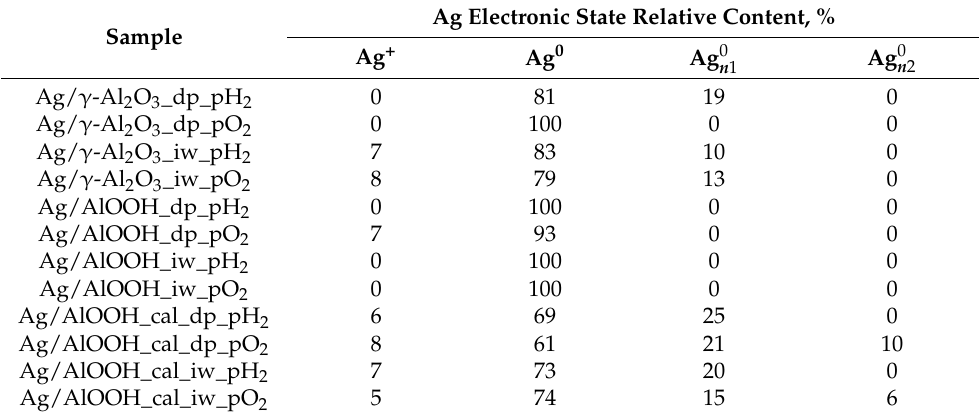
Table 2. Distribution of silver electronic states for the studied catalysts determined by XPS.